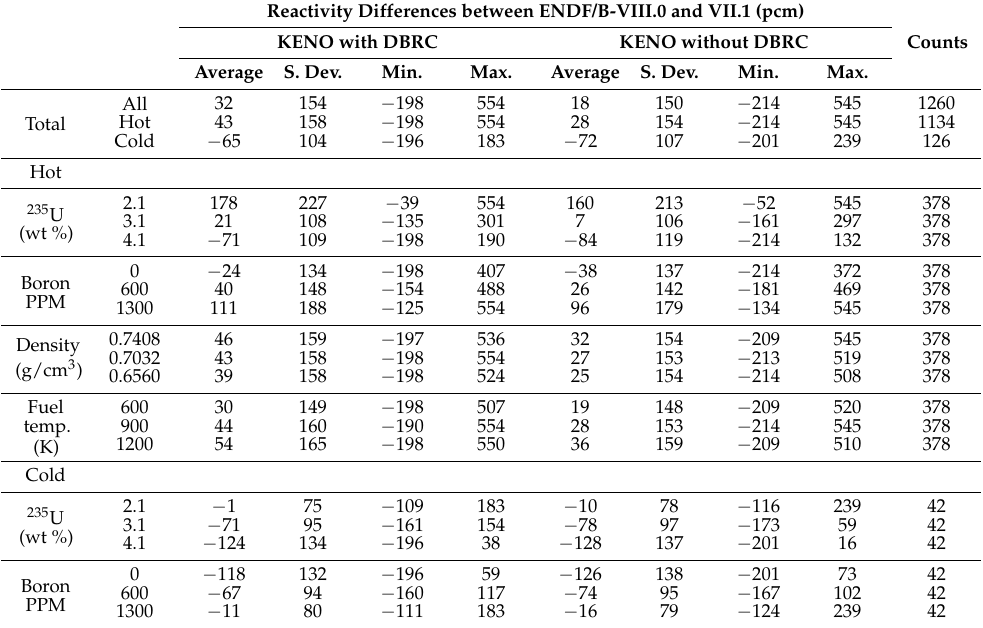
Table 8. Results of the extensive PWR assembly benchmark